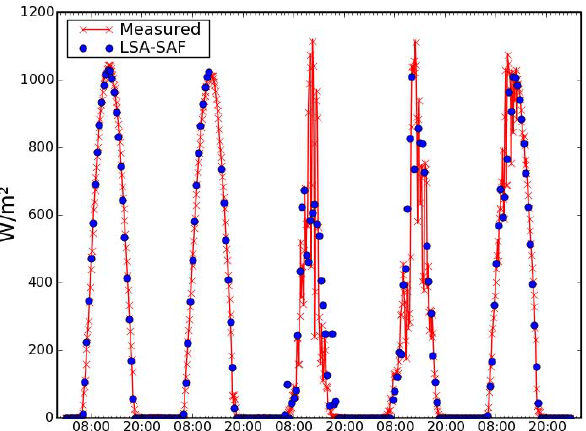
Fig. 4. An hourly estimate of ET 0 computed from NWP forecast data and LSA-SAF radiation